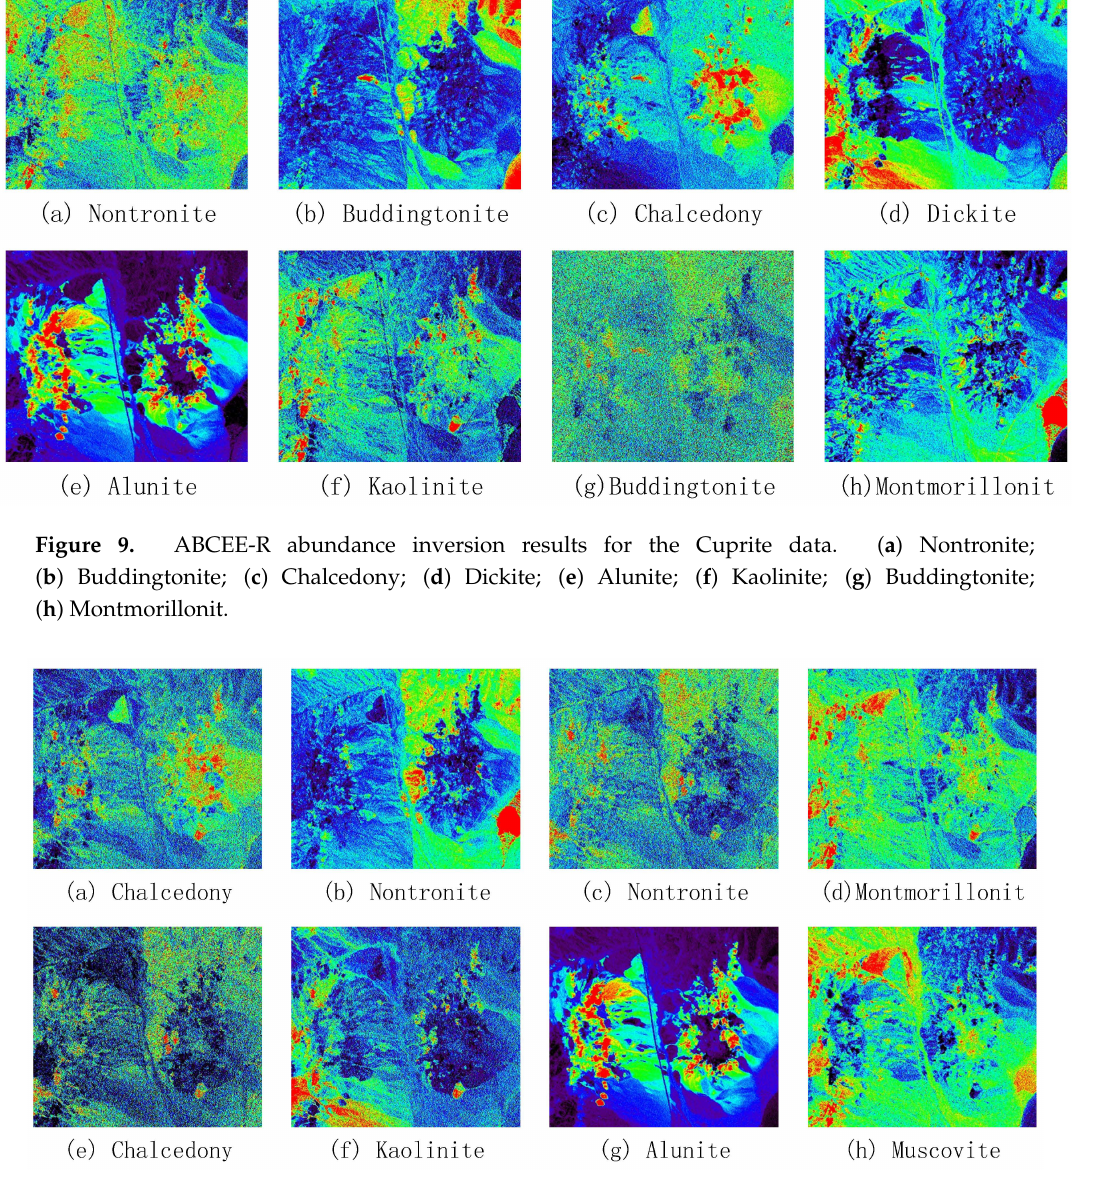
Figure 10. ABCEE-V abundance inversion results for the Cuprite data. ( a ) Chalcedony; ( b ) Nontronite; ( c ) Nontronite; ( d ) Montmorillonit; ( e ) Chalcedony; ( f ) Kaolinite; ( g ) Alunite; ( h )